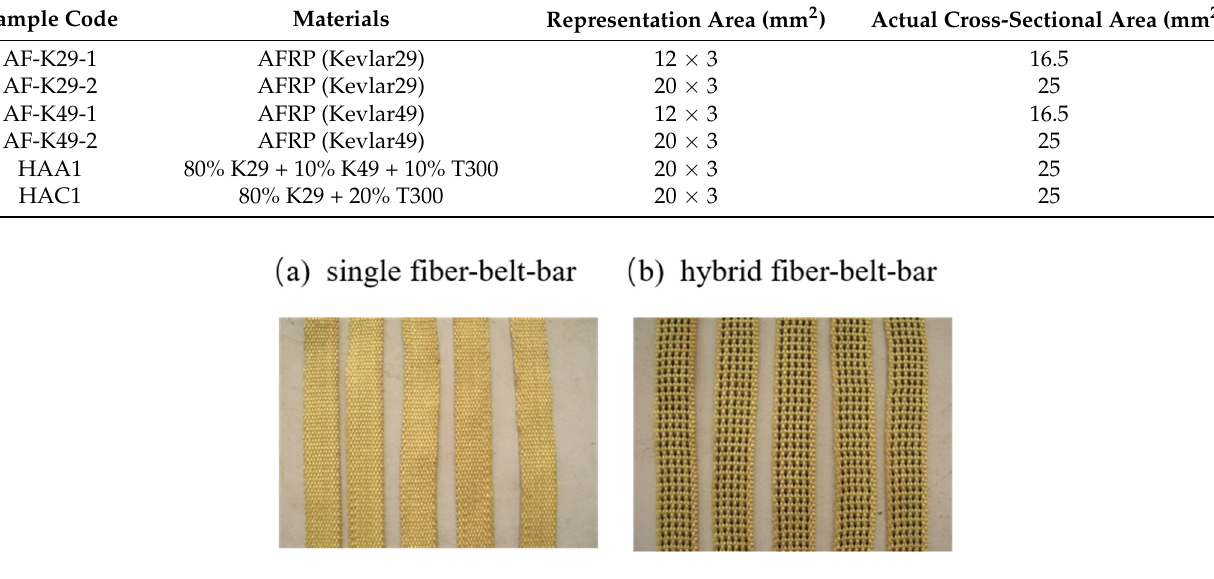
Table 2. Details of the beam specimen parameters.